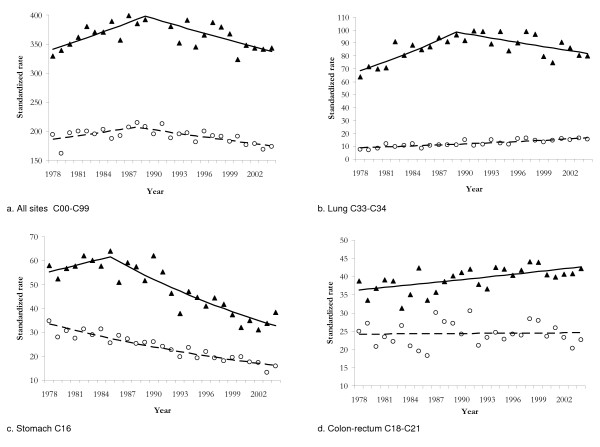
Observed standardized rates per 100.000 inhabitants (▲ males; ○ females) and 'best' joinpoint model estimates (solid line males; dashed line females) for selected cancer sites by gender.